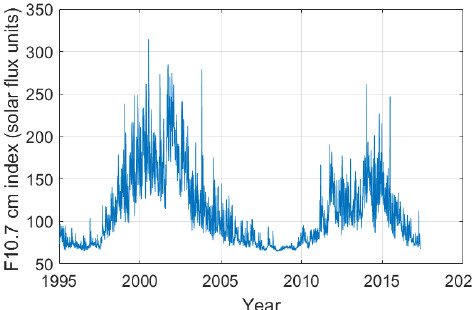
Figure 2. Daily mean F10.7cm flux over time in solar flux units (10 − 22 Wm − 2 Hz − 1 ).